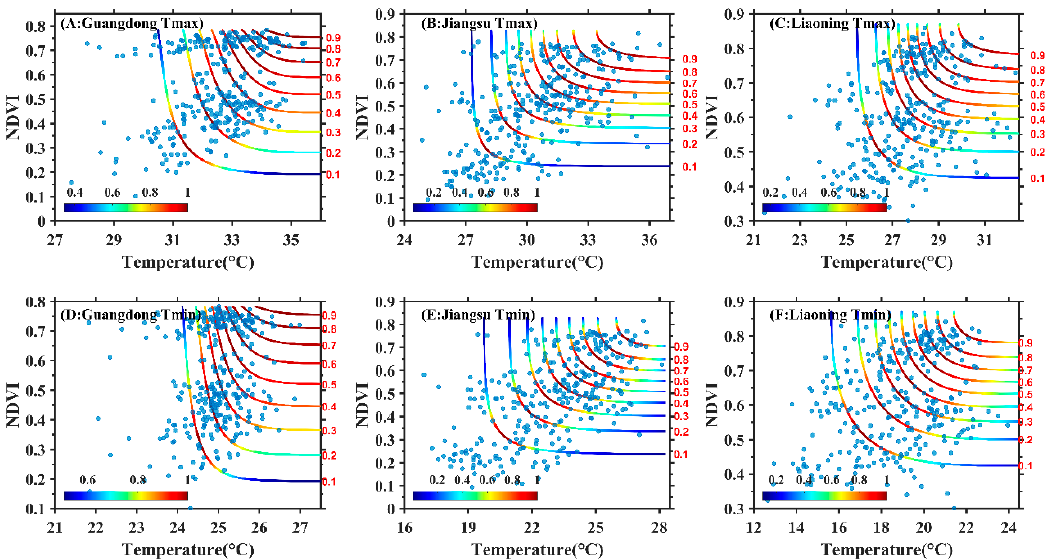
Figure 6. Copula joint probability distributions of Tmax–NDVI and Tmin–NDVI in summer in Guangdong, Jiangsu and Liaoning from 1982 to 2016.